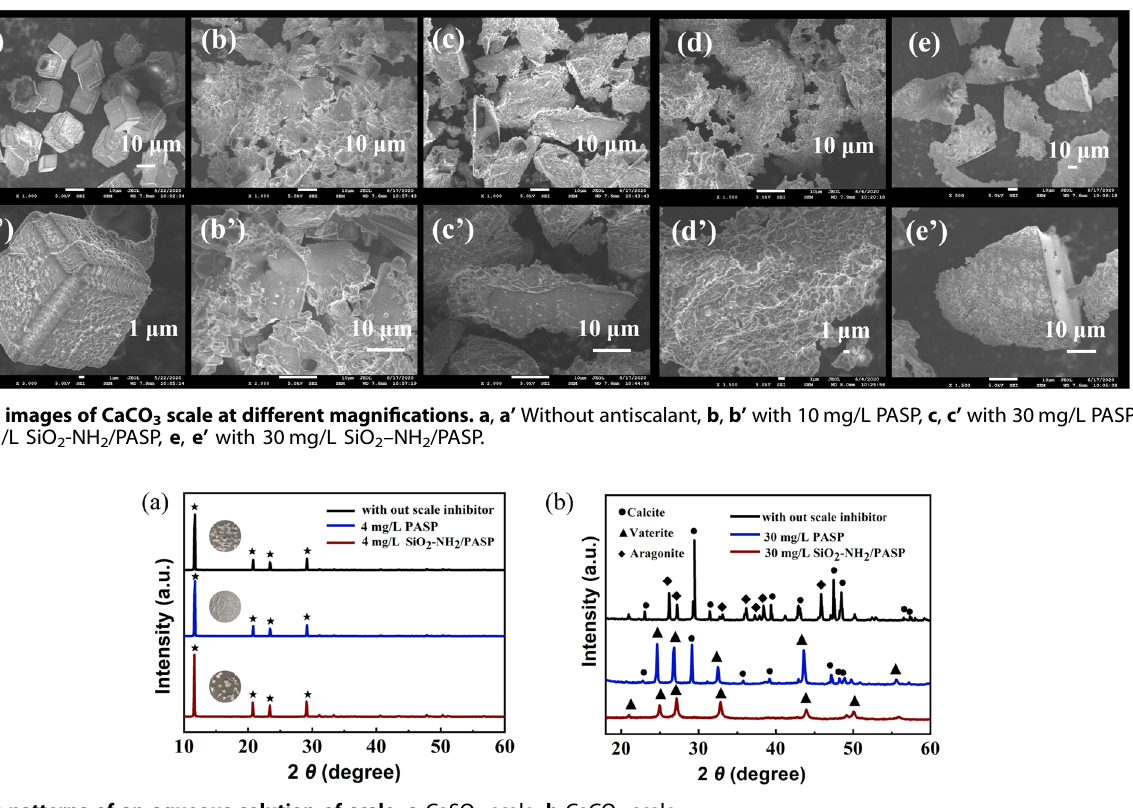
Fig. 7 XRD patterns of an aqueous solution of scale. a CaSO 4 scale, b CaCO 3 scale.